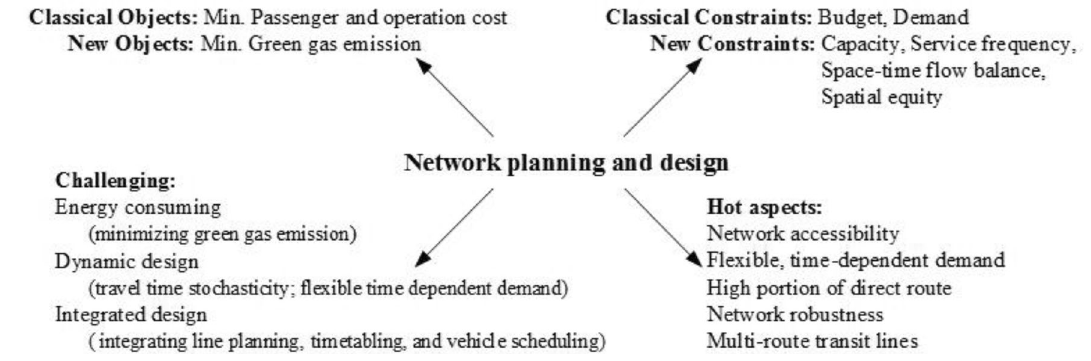
Fig. 3 Objects, constraints, hot topic, and challenges in network planning and